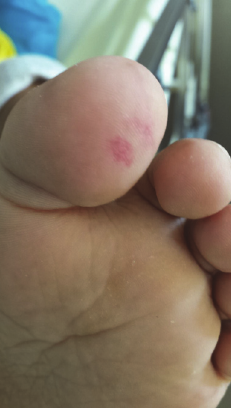
Table 2: Culture results.